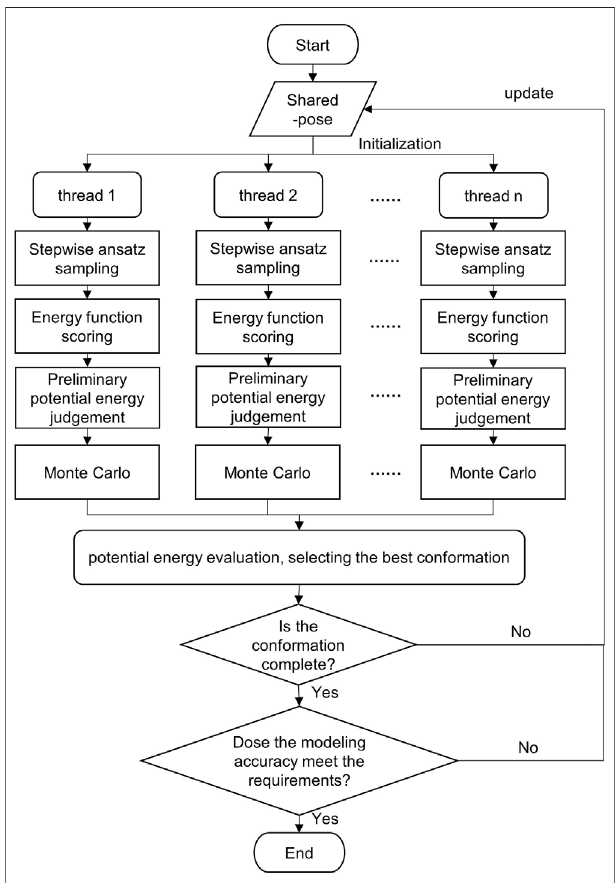
FIGURE 2 | Flowchart of the SMCP